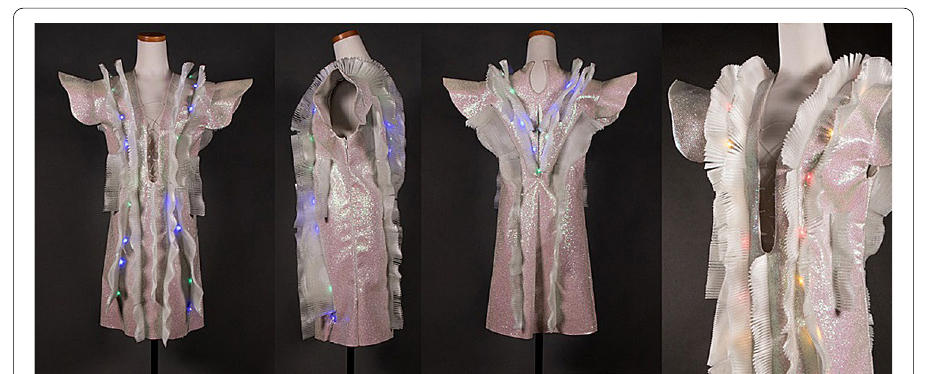
Fig. 2 Final product of ‘Design 1’